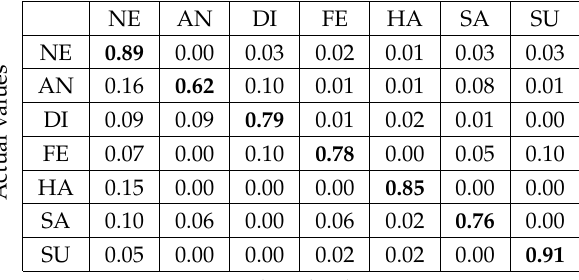
Table 10. Confusion matrix of joint fusion classifier in the MMI dataset. NE, Neutral; AN, Angry; DI, Disgust; FE, Fear; HA, Happy; SA, Sad; SU, Surprise. NE